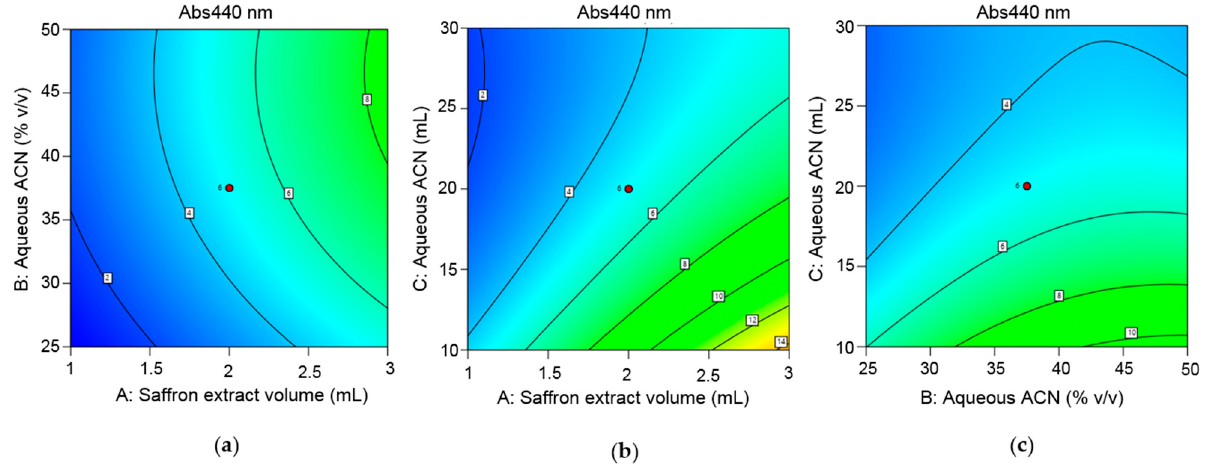
Figure 3. Contour plots of ( a ) volume of saffron extract (mL) and % v / v aqueous can, ( b ) volume of saffron extract (mL) and aqueous ACN volume (mL), ( c ) % v / v aqueous ACN and aqueous ACN volume (mL), for crocins model.